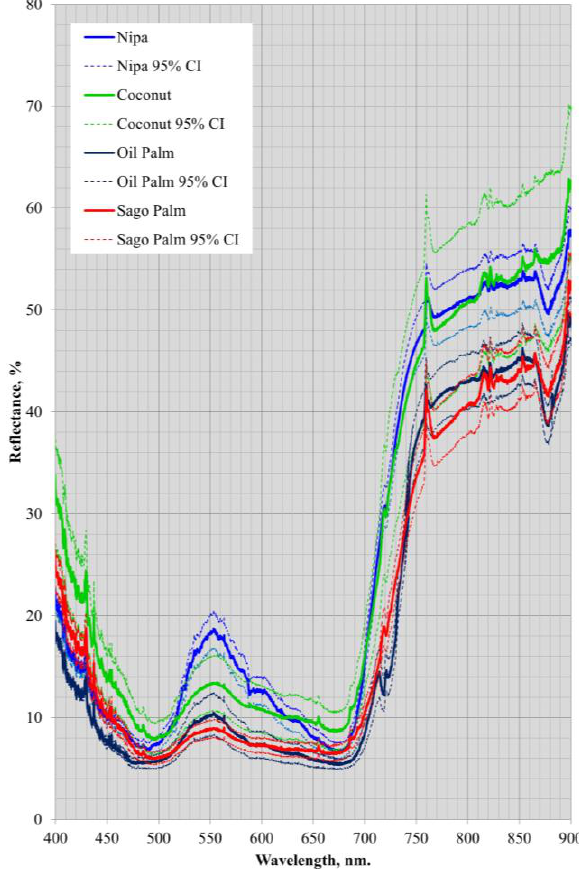
Figure 3. Average in-situ spectral reflectance of Sago and other palms, including the 95% confidence interval of the